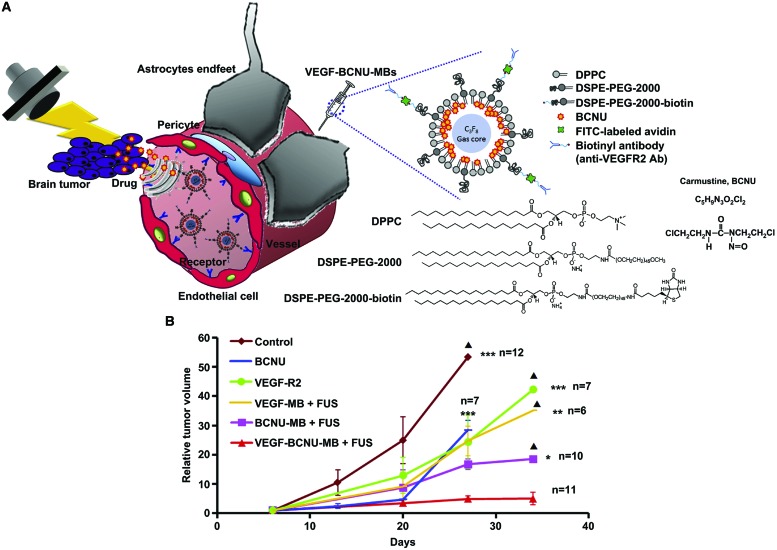
Intracerebral BCNU delivery using VEGFR2-targeted and BCNU-loaded microbubbles with focused ultrasound for the glioma treatment (Adapted with permission from Fan et al., 2013 – Copyright © 2012 Elsevier Ltd.). (A) Antiangiogenic-targeting BCNU-loaded microbubbles combined with focused ultrasound for glioma treatment. (B) Tumor growth curve. BCNU, Carmustine; VEGF-R2, anti-angiogenic antibody; VEGF-MB, VEGF-targeting microbubbles; BCNU-MB, BCNU-loaded microbubbles; VEGF-BCNU-MB, VEGF-targeting BCNU-loaded microbubbles; FUS, focused ultrasound. ∗p < 0.05; ∗∗p < 0.01; ∗∗∗p < 0.001. Solid triangle, less than 3 rats were presented.